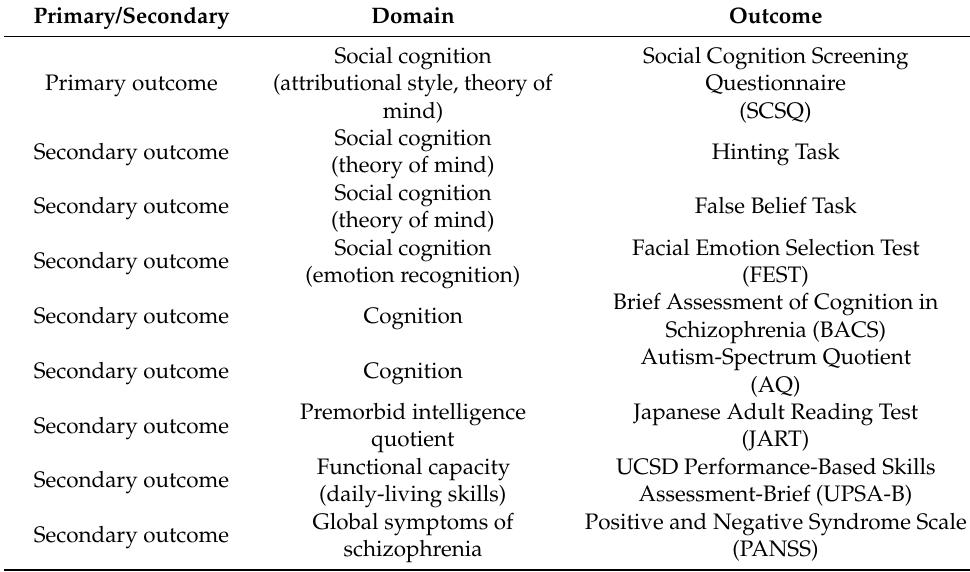
Table 3. Primary/secondary